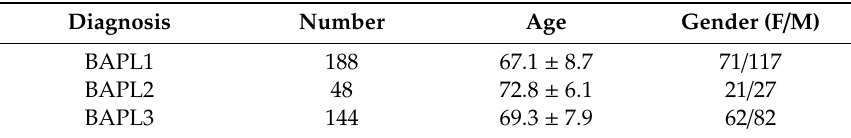
BAPL: brain amyloid plaque load score.